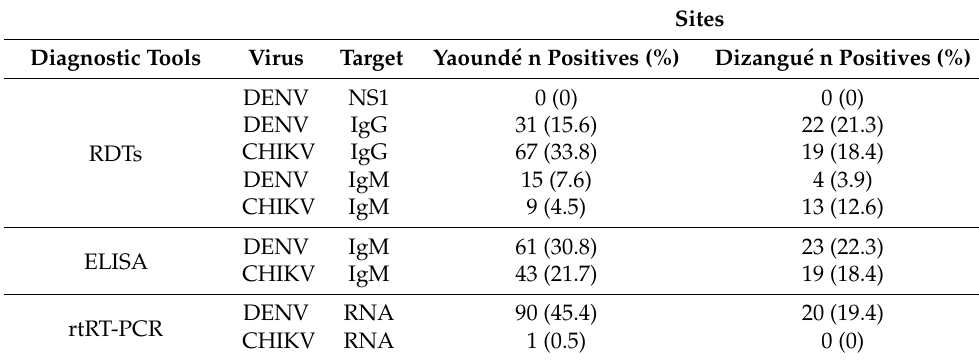
Table 5. Diagnostic tool results, according to study